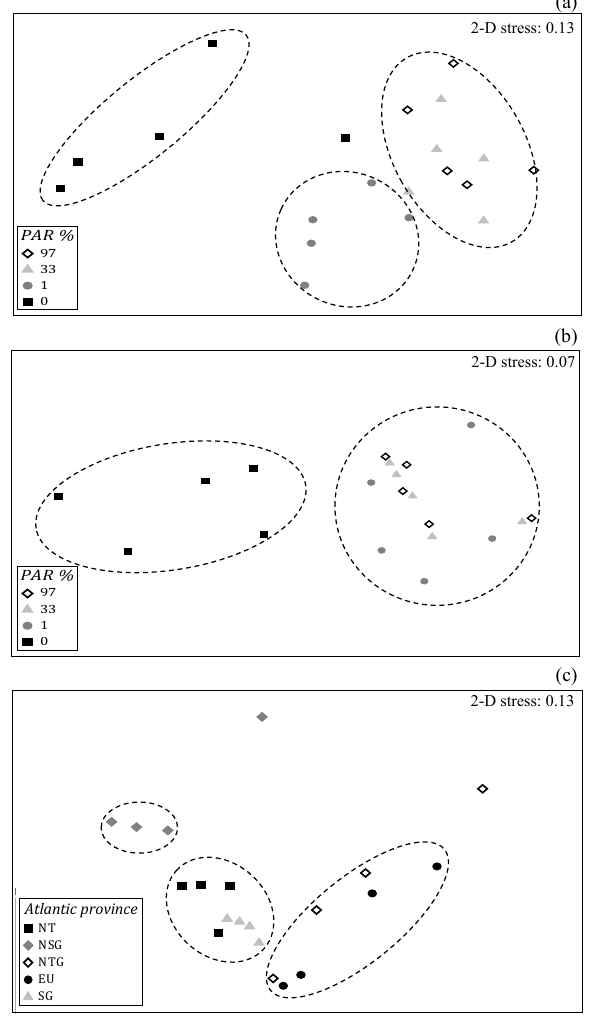
Figure 6. Nonmetric multidimensional scale (MDS) plots of (a) a Bray–Curtis similarity matrix of the 16S rRNA gene sequences of the bacterial community, (b) a Euclidean distance matrix of en- vironmental parameters (salinity, temperature, chl a , primary pro- ductivity, inorganic nutrients, flow cytometry cell numbers, BLI) and (c) a Euclidean distance matrix of rates of methanol dissimi- lation. Dashed lines highlight significant sample groupings. Plots were generated using PRIMER-E (www.primer-e.com, last access: 21 August 2018). (a) and (b) represent samples from 200m, i.e. 0%